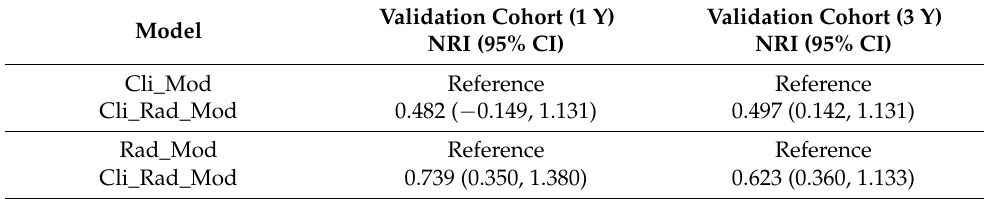
Figure 4. ROC (receiver operating characteristic curve) of different models in training and validation set. Table 5. NRI in validation cohort for the first year and third year.